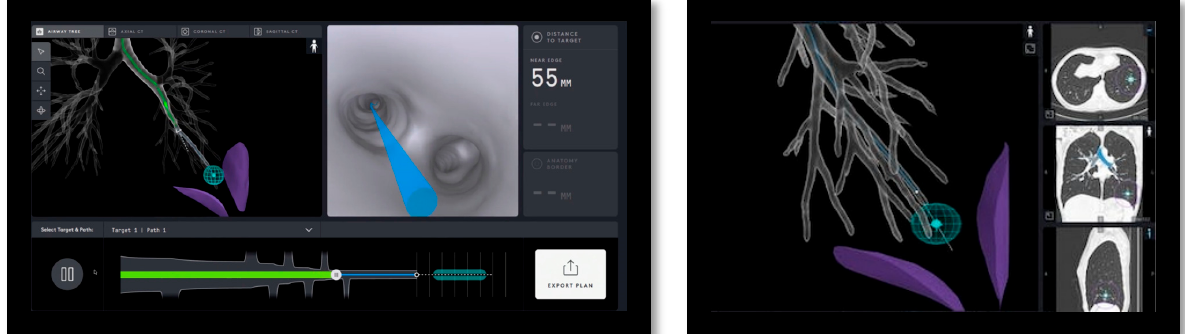
Figure 2. Procedural screenshots from a case. Left screen: Virtual airway view showing catheter within the airway tree. Right screen: Virtual target with target view.